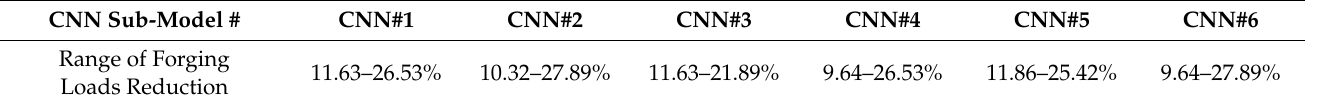
Table 1. Average forging loads reduction in six CNN sub-models.